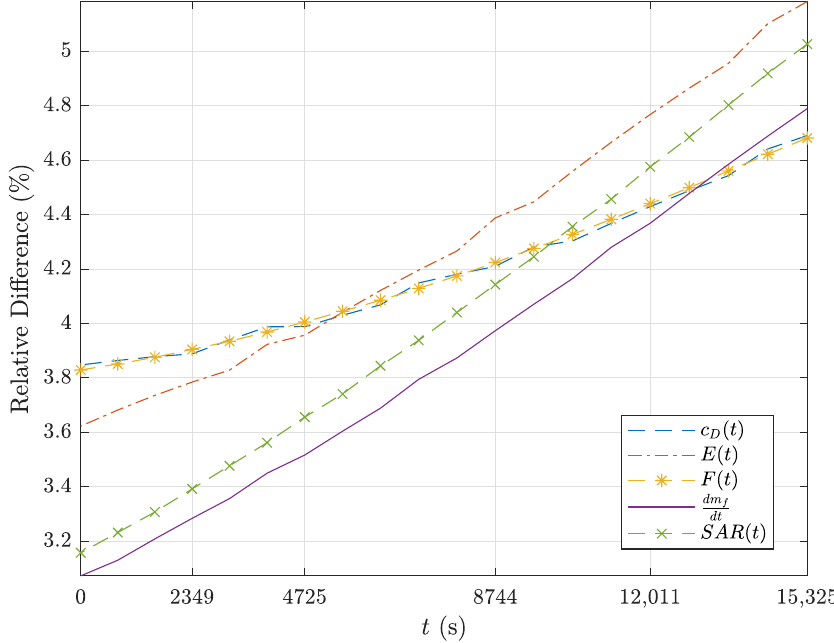
Figure 1. The increasing trend of the relative difference can be observed for all the analyzed perfor- mance parameters, especially for the fuel flow rate and specific air